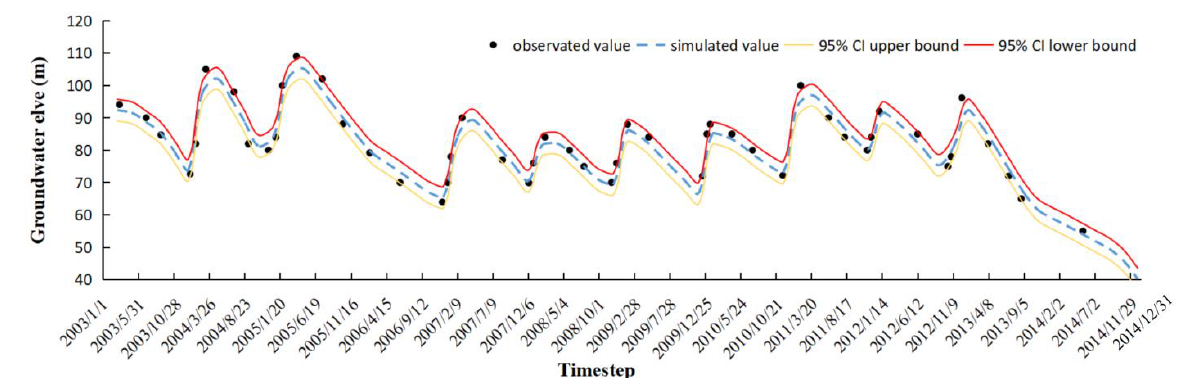
Figure 7. Prediction groundwater level at observation well under 95% confidence interval.